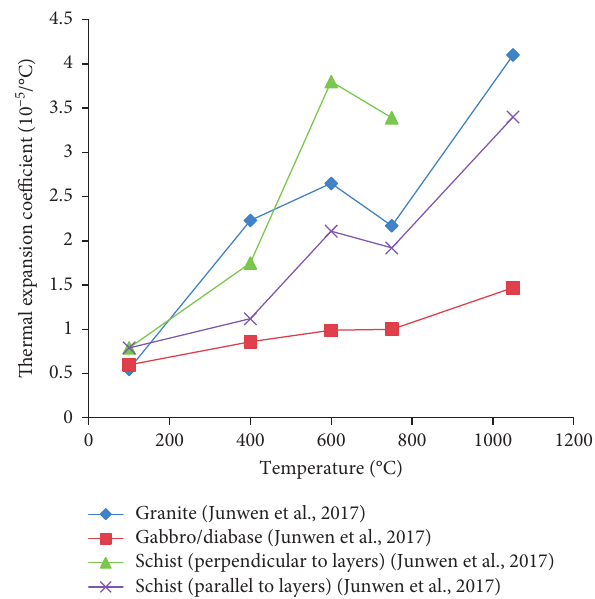
Figure 5: Coefficient of thermal expansion of some rocks as a function of temperature